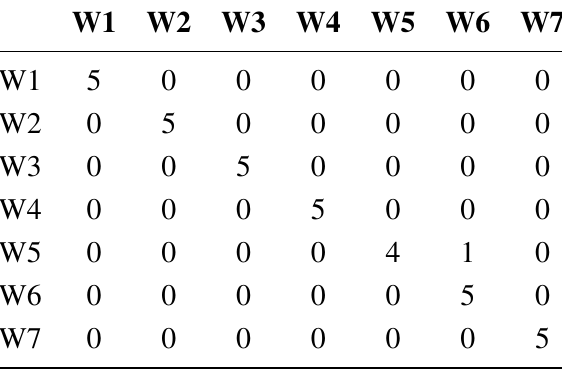
Table 4. Confusion matrix obtained in validation of network with white young